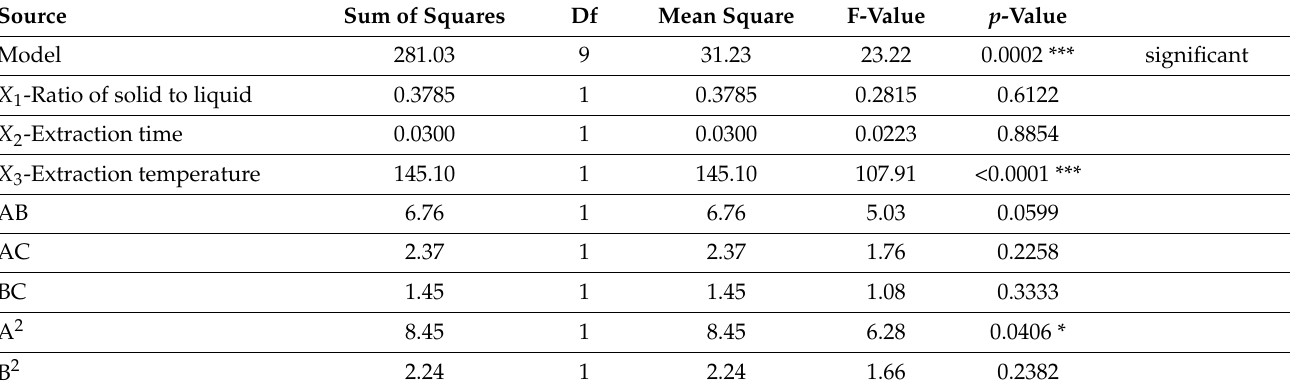
Table 3. Variance analysis of Box-Behnken design results of MAP-2 inhibiting α -glucosidase